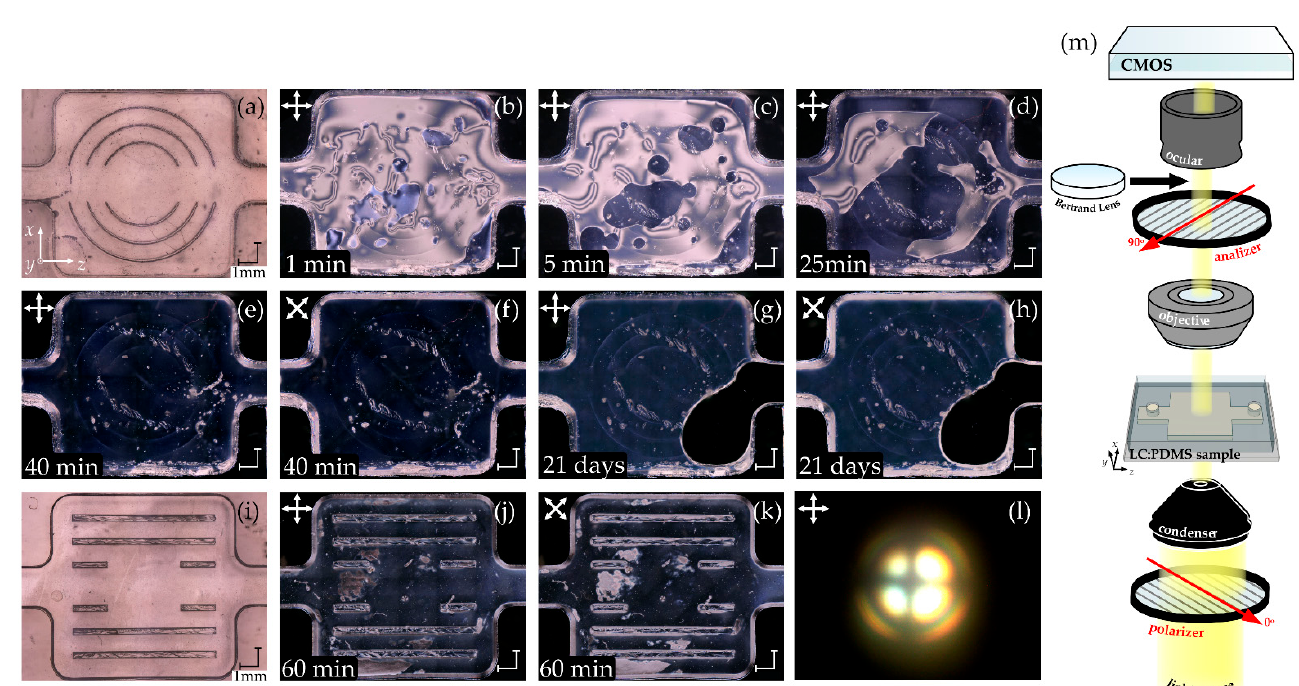
Figure 2. ( a , i ) Photographs of the empty PDMS:PDMS cells applied to determine the liquid crystalline alignment on the PDMS surface. Thin PDMS sub-pillars of semi-cylindrical ( a ) and rectangular ( i ) shapes are visible in the central part of the cell. ( b – h ) POM images of the sample infiltrated with 5CB NLC taken after a particular time indicated on the bottom left corner of the photographs. ( j , k ) PDMS:PDMS cell with E7 NLC inserted in different angular positions between crossed polarizers and observed 60 min after infiltration. The black gridded pattern visible in some photographs is an artifact resulting from a photo-stitching procedure in the digital microscope. ( l ) Conoscopic image in the central part of the tested cells proving the homeotropic alignment. ( m ) Scheme of the polarization of the optical microscope. The passage from the typical orthoscopic mode to the conoscopic configuration is obtained by introducing a Bertrand lens between the ocular and the analyzer.